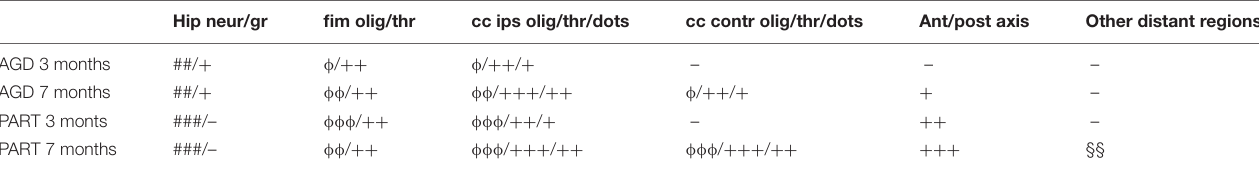
TABLE 2 | Semi-quantitative representation of lesions following inoculation of sarkosyl-insoluble fractions of AGD and PART at survival times of 3 months (AGD, n = 4; PART, n = 2) and 7 months (AGD, n = 3; PART, n = 7). Hip neur/gr fim olig/thr cc ips olig/thr/dots cc contr olig/thr/dots Ant/post axis Other distant regions